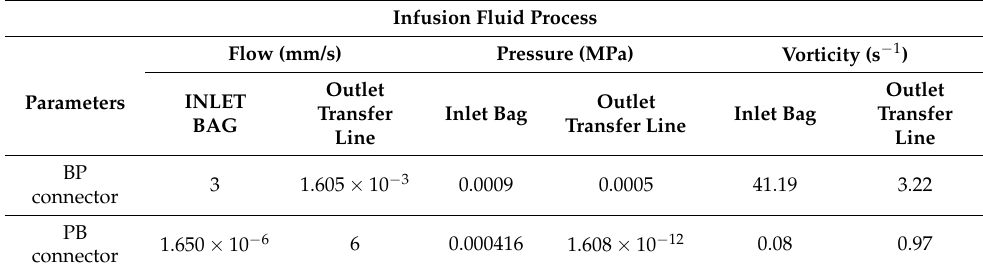
Table 7. Flow, pressure, and vorticity behavior of the fluid in the BP and PB connectors in the in- fusion process.